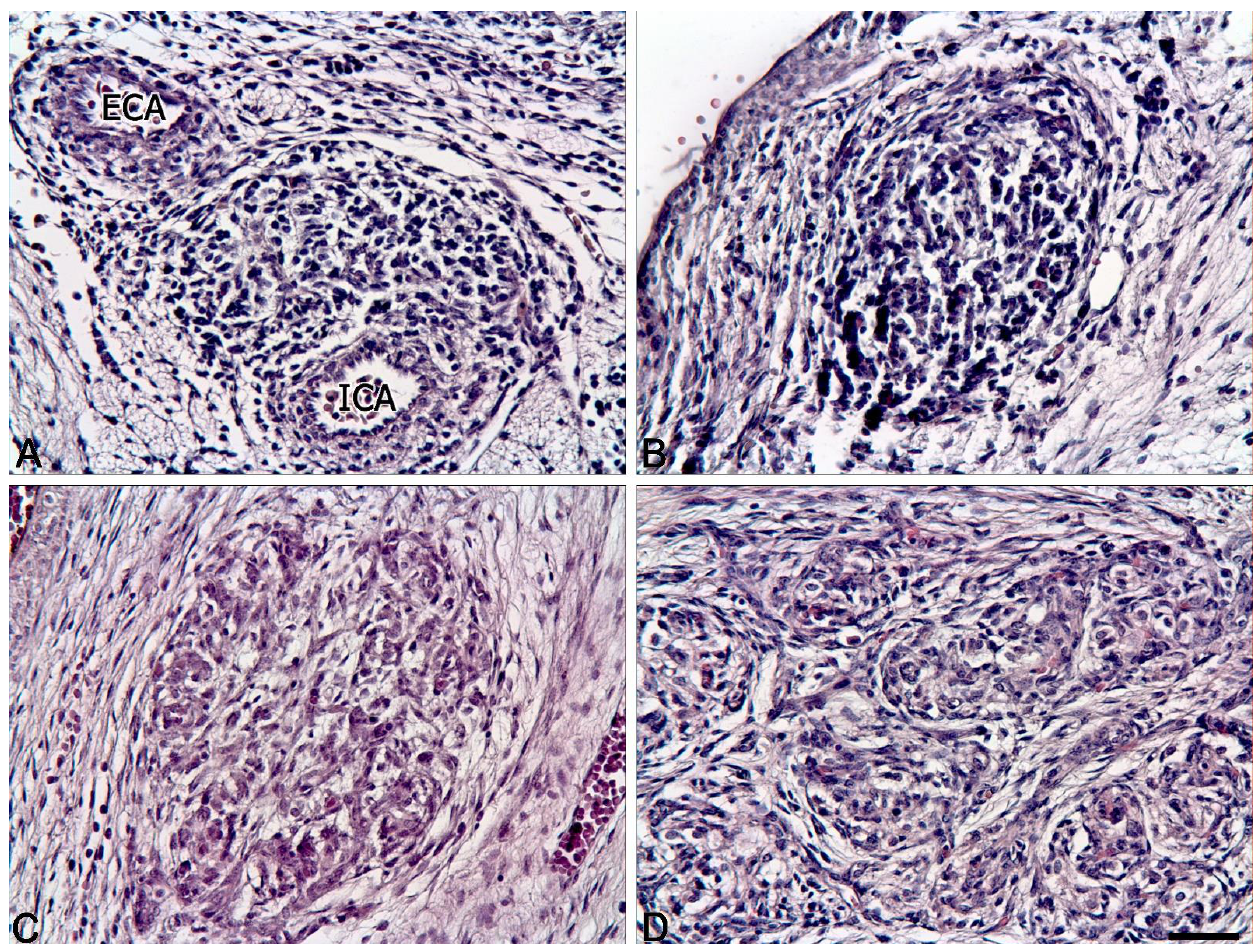
Figure 1. The human carotid body in the antenatal period: ( A ) 8 PCW embryo; ( B ) 10 PCW prefetus; ( C ) 13 – 14 GW fetus; ( D ) 19 – 20 GW fetus. ECA, external carotid artery, ICA, internal carotid artery. H&E stain. Bar = 50 μm.